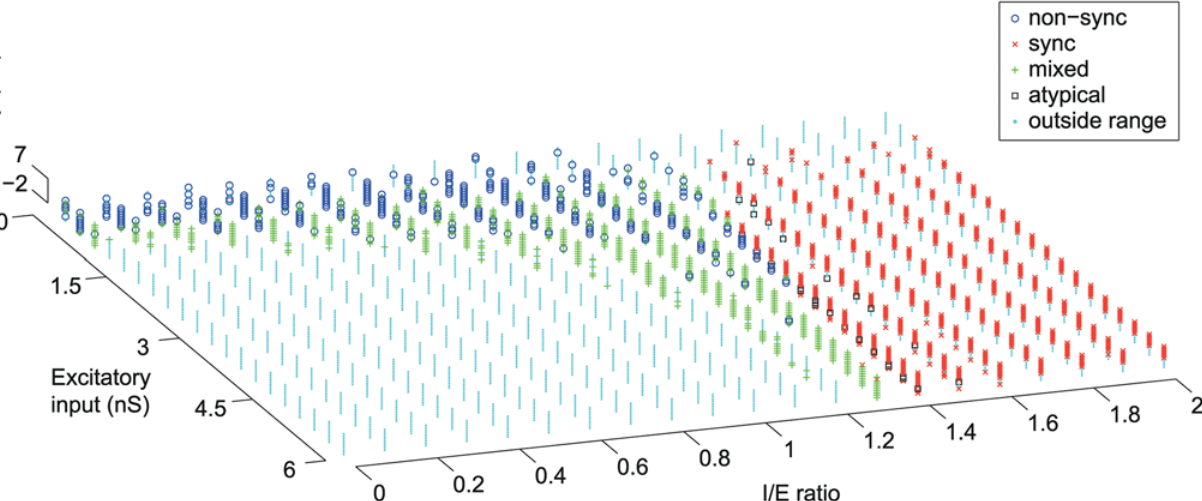
Fig 3. Dependence on input parameters of computational model. Classification of neuron-type [non-sync (o), sync (x), mixed (+), atypical (square)] across all three parameters (I-E delay, Excitatory input, and I/E ratio). If pure tone responses were less than 1 spk/s or greater than 50 spk/s, neurons were considered to have responses outside the allowable range (cyan) and were not included in our